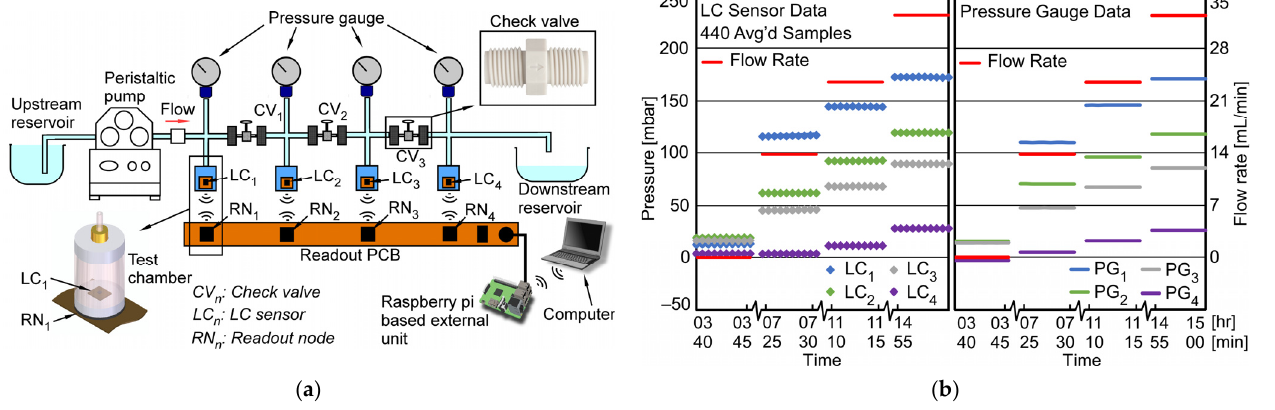
Figure 9. ( a ) Flow test setup illustrating LC sensors (LC n ) and wired pressure gauges (PG) in flow path with wirelessly coupled Readout nodes (RN n ). Check valves (CV n ) create pressure drop. ( b ) Measured pressure of LC sensors (LC n ) and flow rate during flow experiment at 25 °C (left), and measured pressure of wired gauges (PG n ) during flow experiment (right). Error bars for measurement resolution not visible at scale (95% confidence interval: <1.5 mbar).